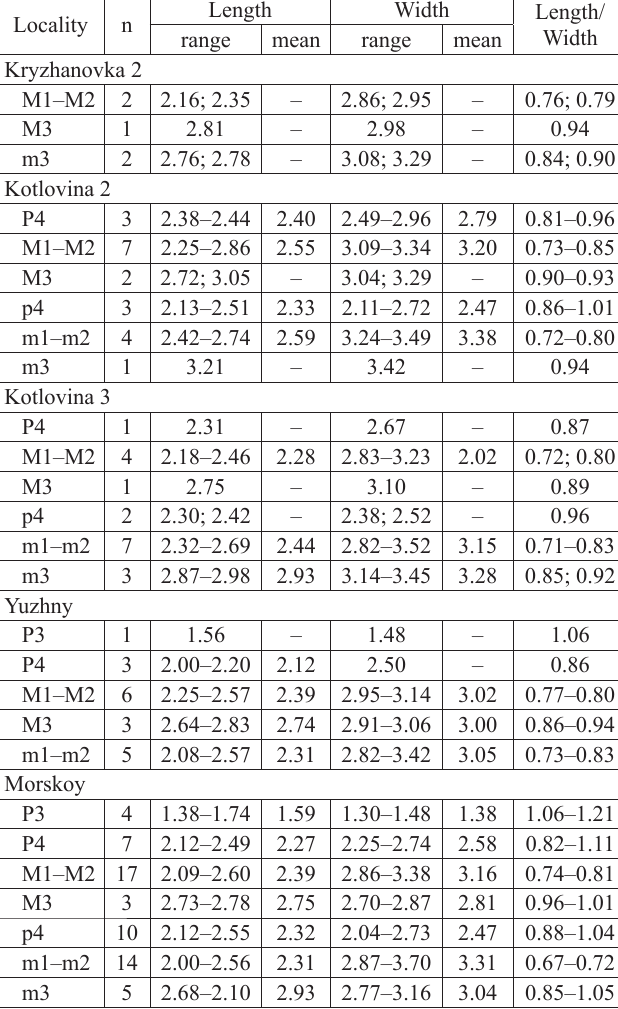
Table 2. Dental measurements (in mm) of Spermophilus praecox sp. nov. Length Width Length/ Locality n Widthrange mean range mean Kryzhanovka 2